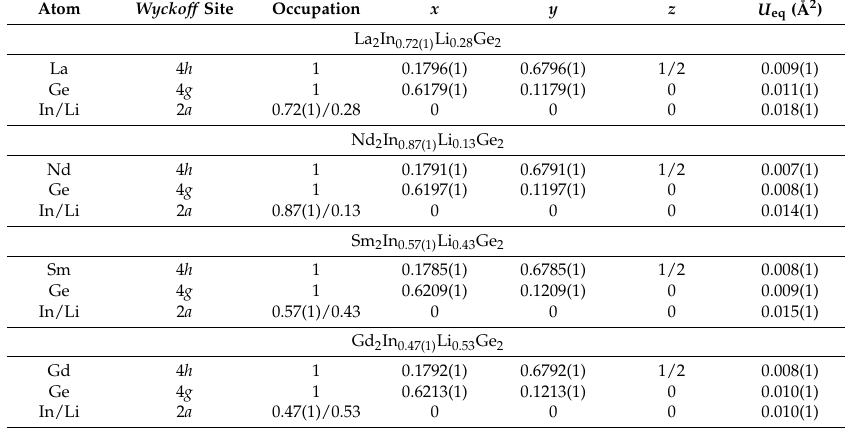
Table 2. Atomic coordinates and equivalent isotropic displacement parameters ( U eq a ) from the